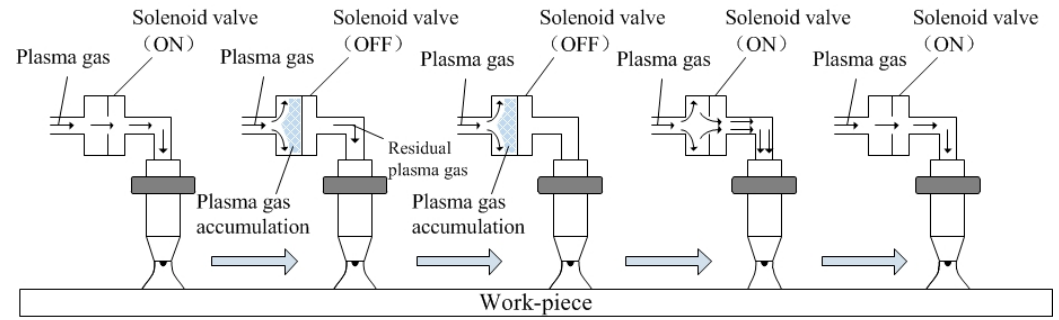
Figure 2. The principle of PPG-VPPAW process.